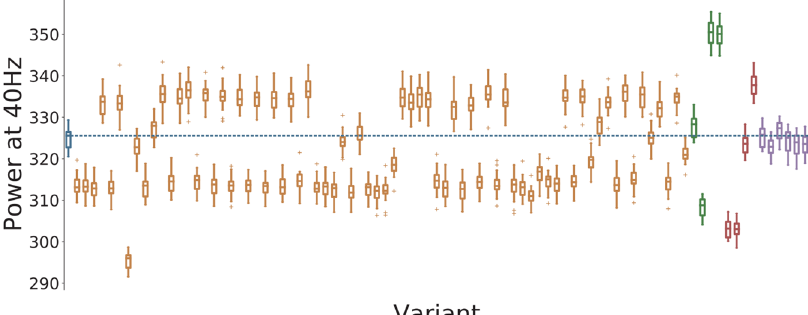
Fig. 2 Overview of the 4040 measure for all variants. Control network in blue, blue dashed line represents the mean of the control group, Ca 2 + channel variants affecting Ca HVA in orange, Ca 2 + channel variants affecting Ca LVA in green, HCN variants in red, and SCN variants in purple. For each color-coded group of variants the ordering matches the ordering in Supplementary Tables 3, 4 and 5, respectively. Solid lines represent the mean, box edges the 25 and 75 percentile, respectively, the whisker extend to 2 standard deviations and + depict outliers. The dashed blue line represents the mean of the control